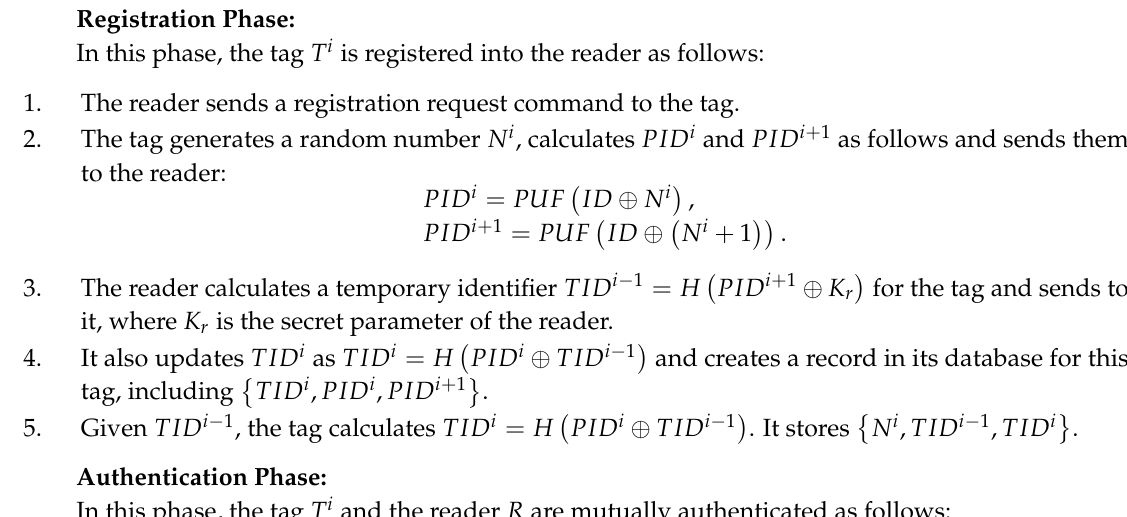
Figure 3. The improved PUF-based